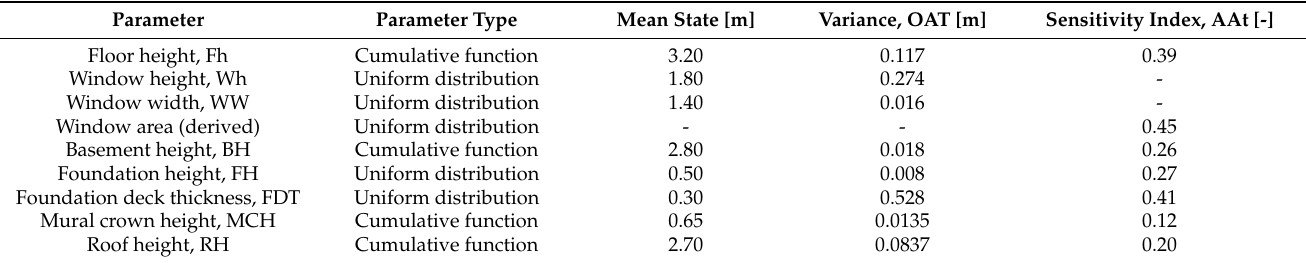
Table 6. Essential free parameters identified for housing constructed between 1931 and 1950.